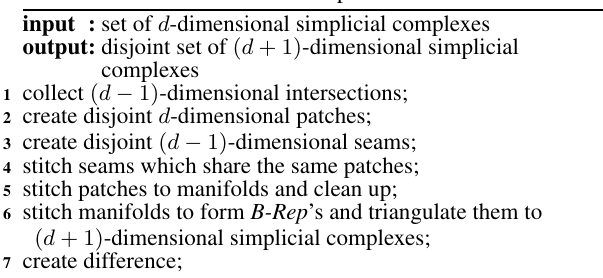
Algorithm 1: computing d -dimensional simplicial net- works into d + 1 -dimensional simplicial networks